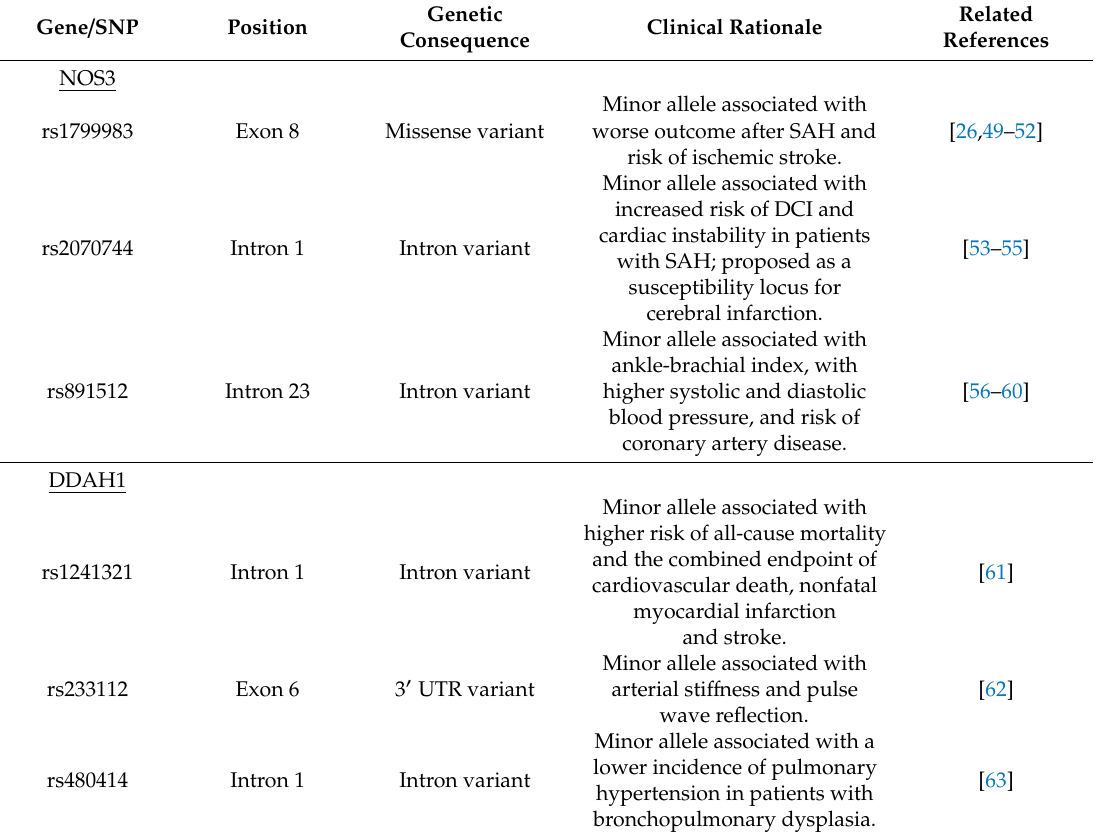
Table A1. Summary of SNPs selected for this study and their previously published associations with clinical